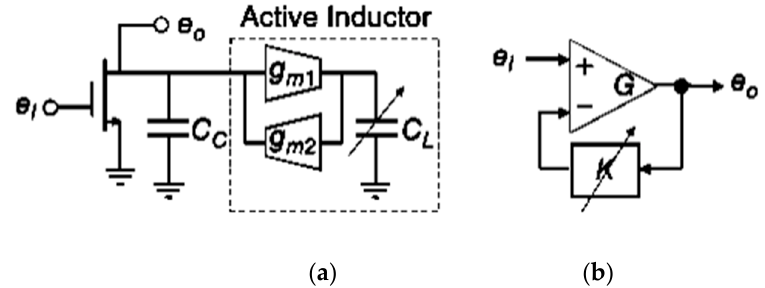
Figure 8. Active reconfigurable filter: ( a ) Active inductor-based filter [53]; ( b ) Recursive filter [45].